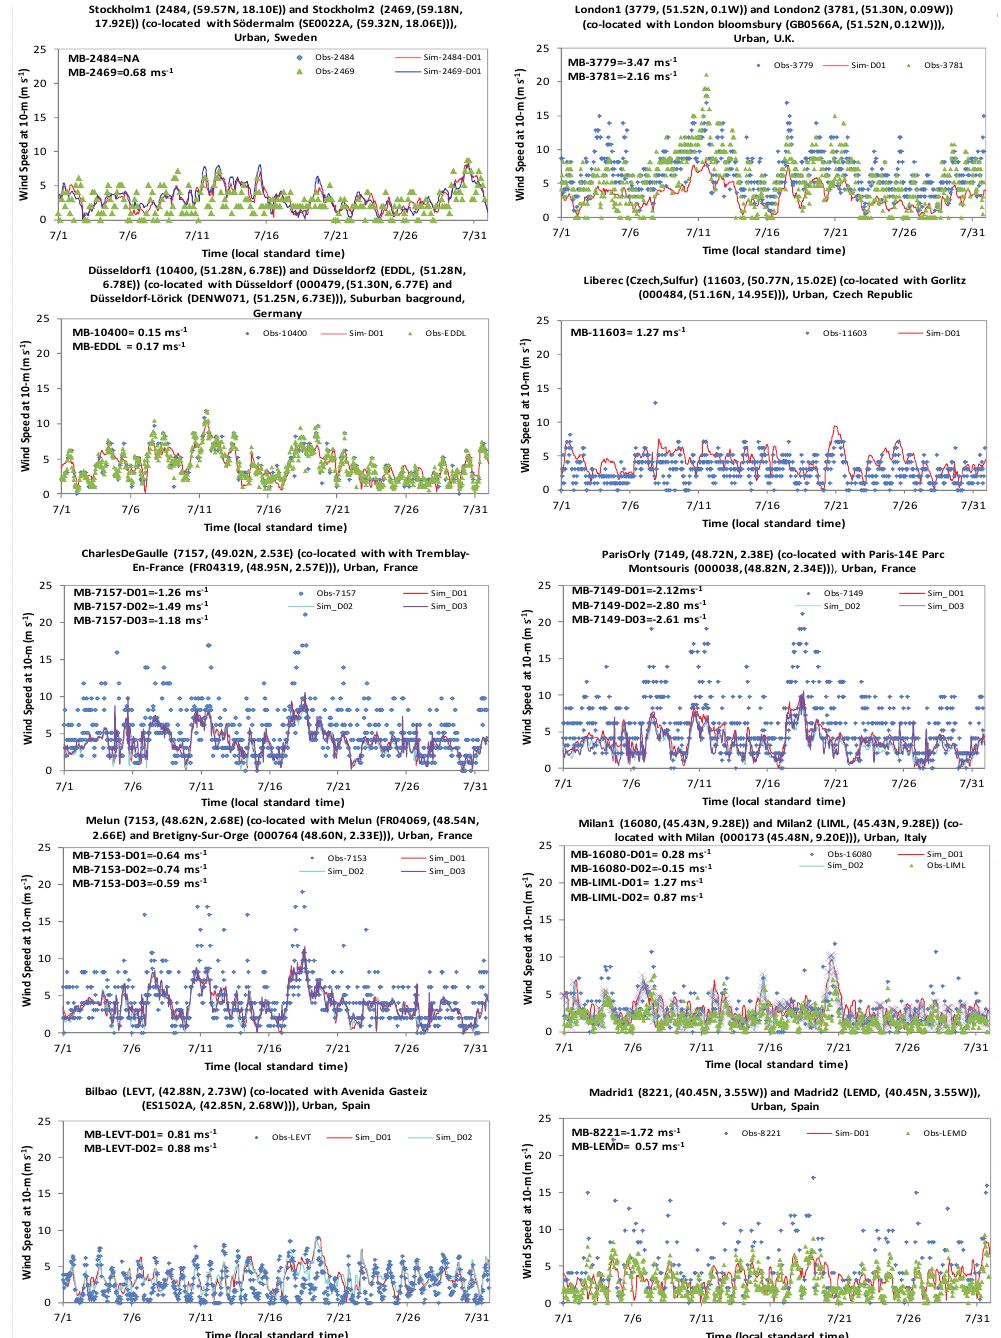
Figure 13. Simulated and observed 10-m wind speed in July 2001 at selected sites. Statistics is not available (NA) at one site (Stockholm 1) where observations were not available.